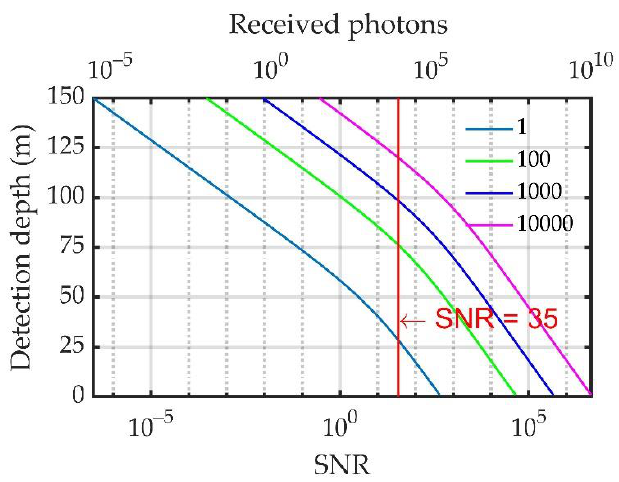
Figure 16. Relationship between the SNR and detection depth under different accumulation numbers.